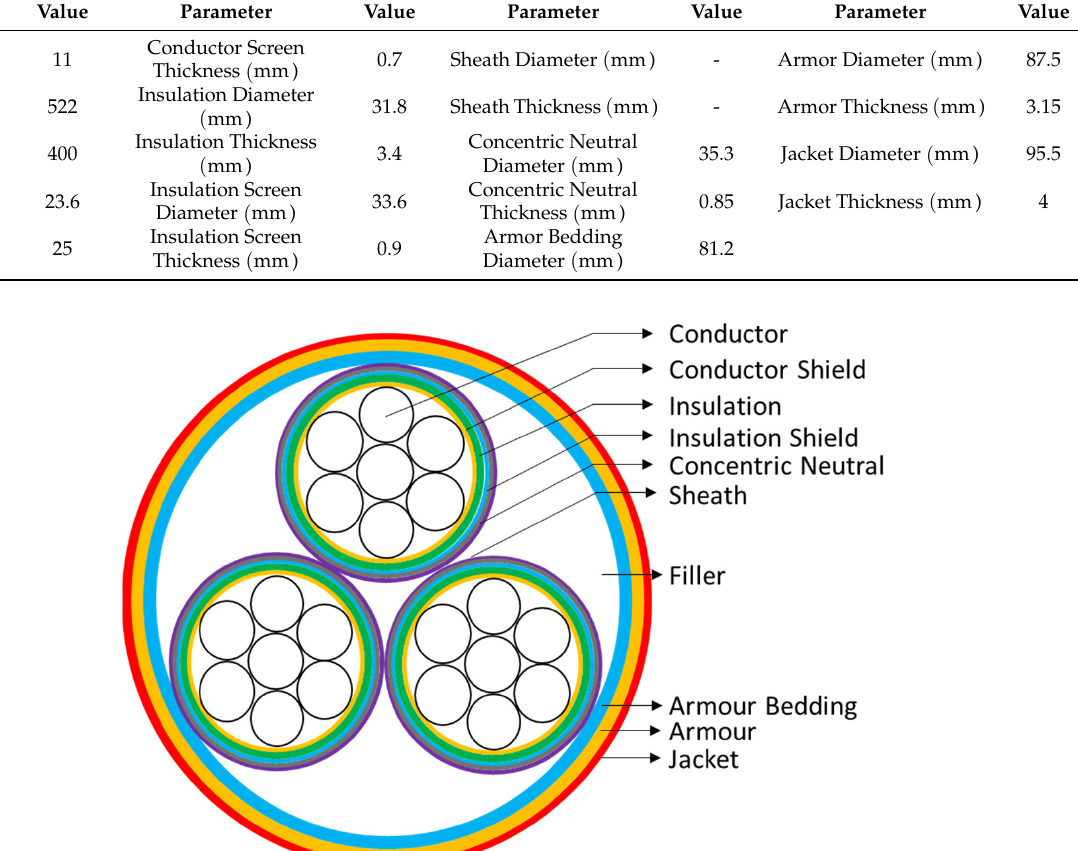
Table 1. Specification of the 400 mm 2 11 kV XLPE cable.